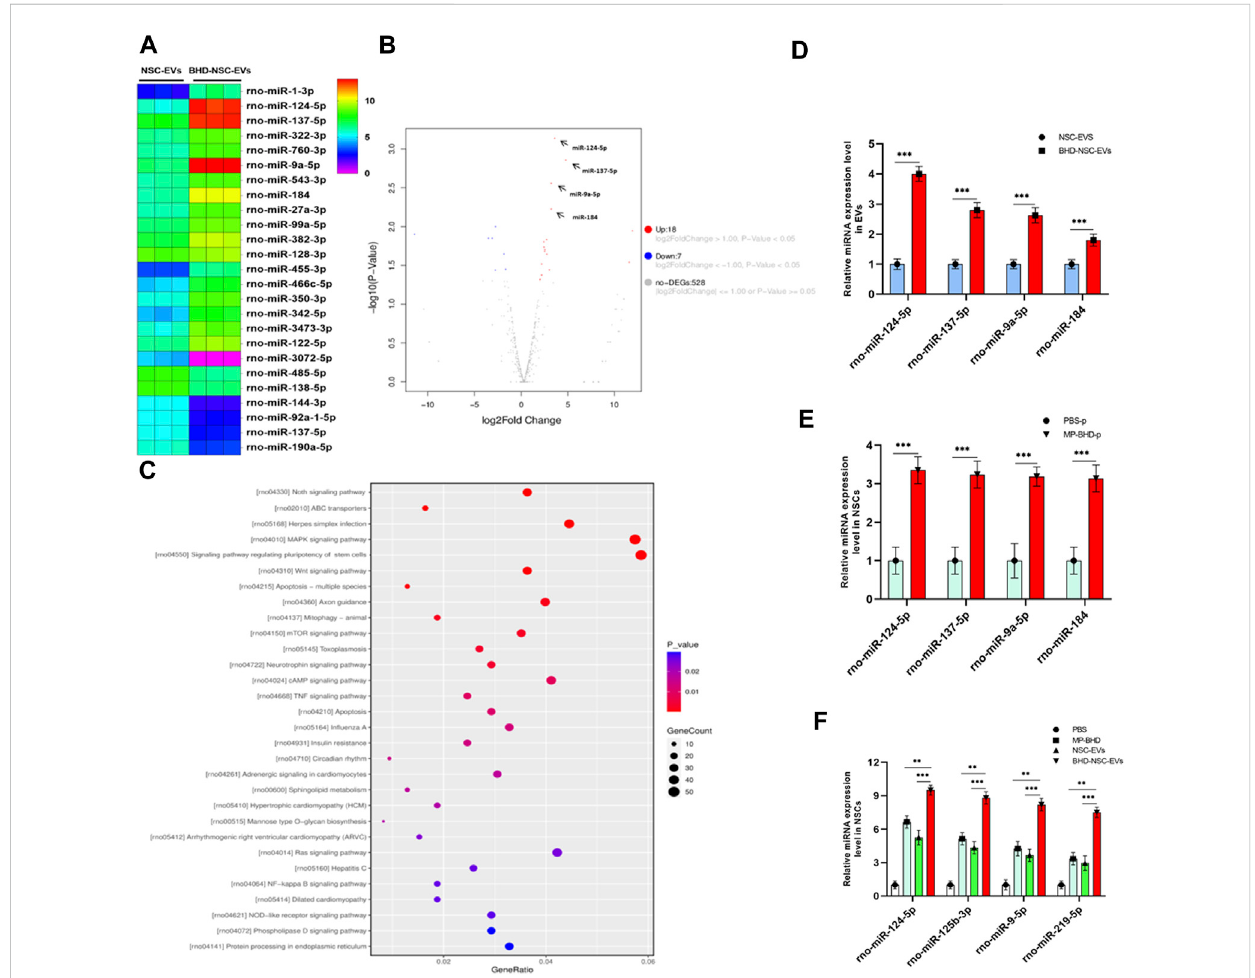
FIGURE 7 A mechanism for the neurogenesis of BHD-NSC-EVs by changing the miRNAs Pro fi les. (A) Heat map shows that 25 miRNAs exhibit Differential expression abundance in BHD-NSC-EVs and NSC-EVs. miR-124-5p, miR-9a-5p, miR-137-5p, and miR-184 are the top four of the upregulated miRNAs with markedly greater readcount. (B) Volcano plot analysis for the differentially miRNA expression in BHD-NSC-EVs vs. NSC-EVs. Red, signi fi cantly upregulated miRNAs; blue, signi fi cantly downregulated miRNAs; gray, no signi fi cant difference. Fold change > 2 and p < 0.05 were considered signi fi cant. ( n = 3/group). (C) KEGG pathway analysis of the target genes of the top four of the upregulated miRNAs encapsulated BHD-NSC-EVs. Top 30 enriched pathways are indicated. (D) qPCR analysis showed the relative miRNA expression level of the top 4 of the upregulated miRNAs encapsulated in BHD-NSC-EVs and NSC-EVs, ( n = 5/group), Data were normalized to levels of U6, *** p < 0.001. (E) qPCR analysis showed the relative miRNA expression levelofthetopfouroftheupregulatedmiRNAsinNSCsafter12 hofMP-BHDorPBStreatment.( n =5/group),Datawerenormalizedtolevels of β -Actin, *** p < 0.001. (F) qPCR analysis showed the relative miRNA expression level of the top four of the upregulated miRNAs in recipient NSCs after 12 hofBHD-NSC-EVs,NSC-EVs,MP-BHDorPBStreatment.( n =5/group).Datawerenormalizedtolevels of β -Actin, * p < 0.05,** p < 0.01.*** p < 0.001. All data are from three independent experiments and are presented as mean ± s.e.m,two-sided Student ’ s t -tests were used for comparisons (D – F)